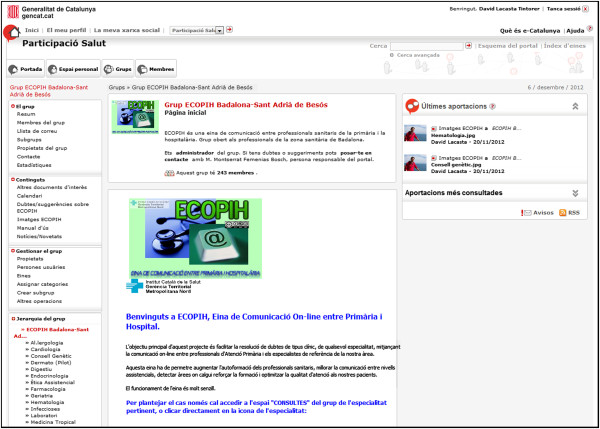
Home page of ECOPIH.